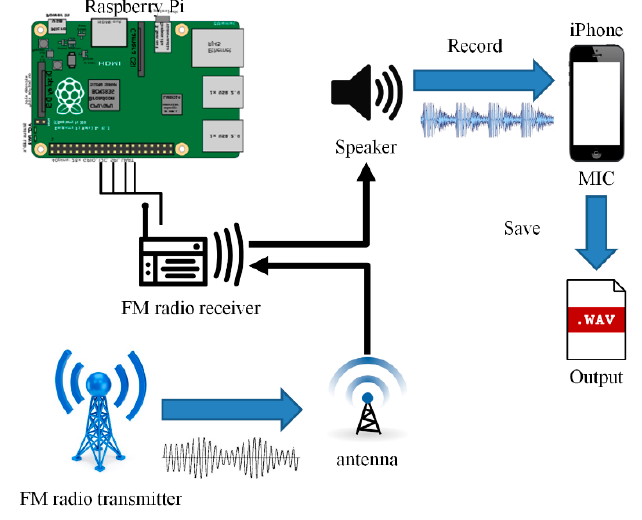
Figure 1. System design.